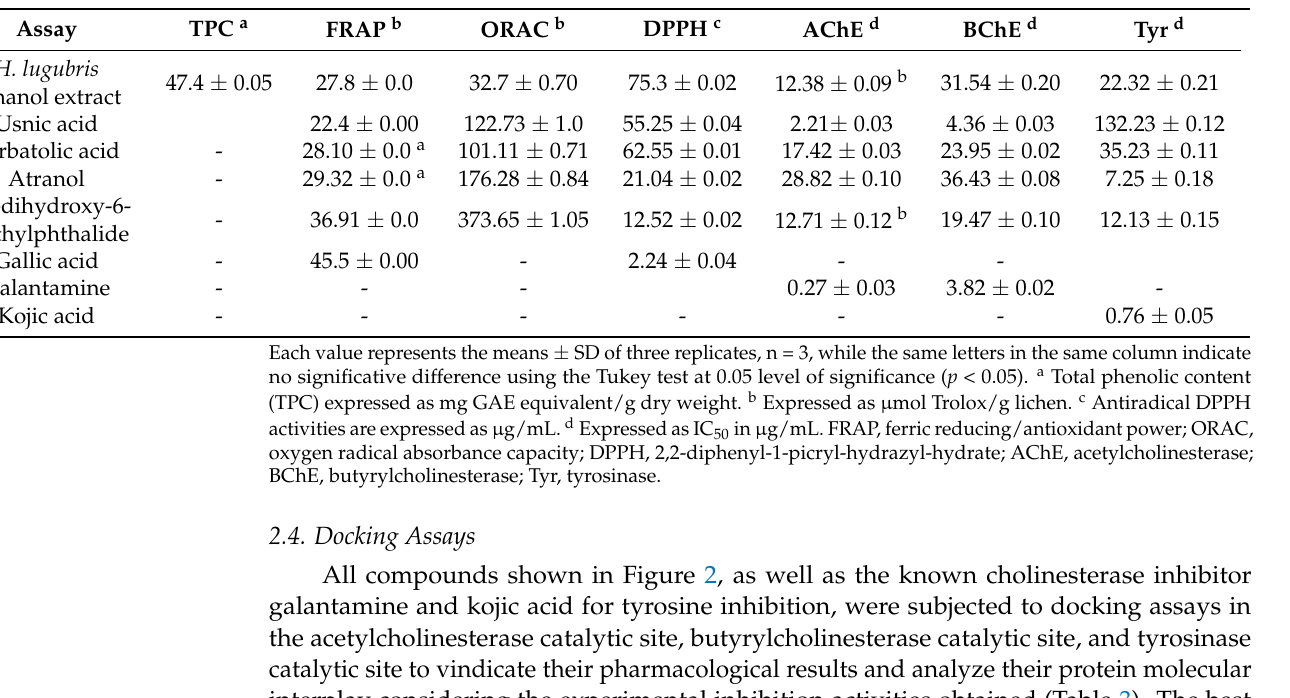
Table 3. Total phenolic content (TPC), antioxidant activity (FRAP; ORAC, DPPH) and enzymatic inhibitory activity of H. lugubris